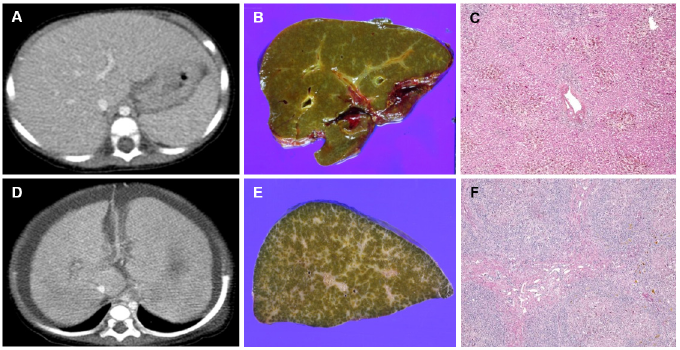
Fig 1. Contrast-enhanced axial CT scans for hepatic parenchymal changes. (A) Normal hepatic morphology in a 7-month-old girl with Alagille syndrome. (B, C) Macroscopic (B) and microscopic (C) specimens of the liver show cholestasis with paucity of interlobular bile duct, but parenchymal destruction is relatively mild (original magnification of microscopic image: x40). (D) Hepatic parenchymal changes with heterogeneous enhancement, fissure widening, left lobe hypertrophy, and periportal edema in a 5-month-old girl with biliary atresia. Note the presence of ascites and gastroesophageal varix. (E, F) Macroscopic (E) and microscopic (F) specimens of the liver show cholestasis and cirrhotic changes with marked parenchymal destruction (original magnification of microscopic image: